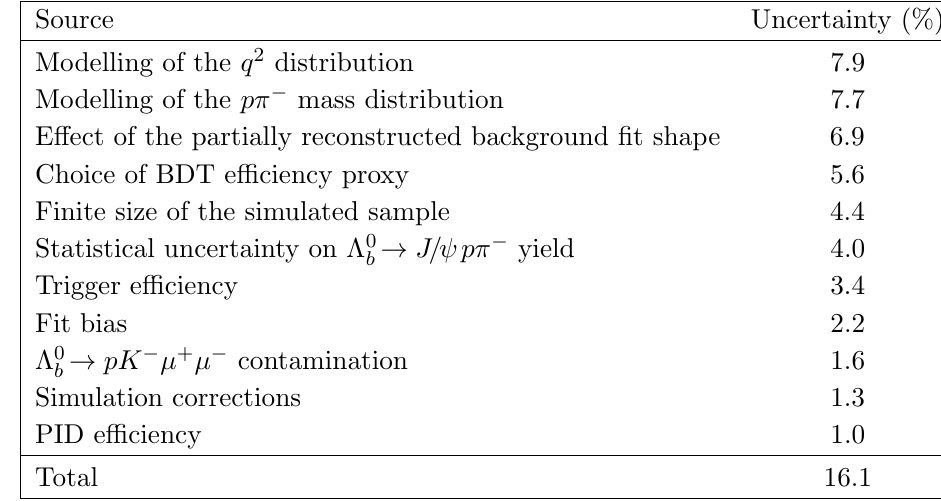
Table 1 . Summary of the systematic uncertainties on the (cid:3) 0